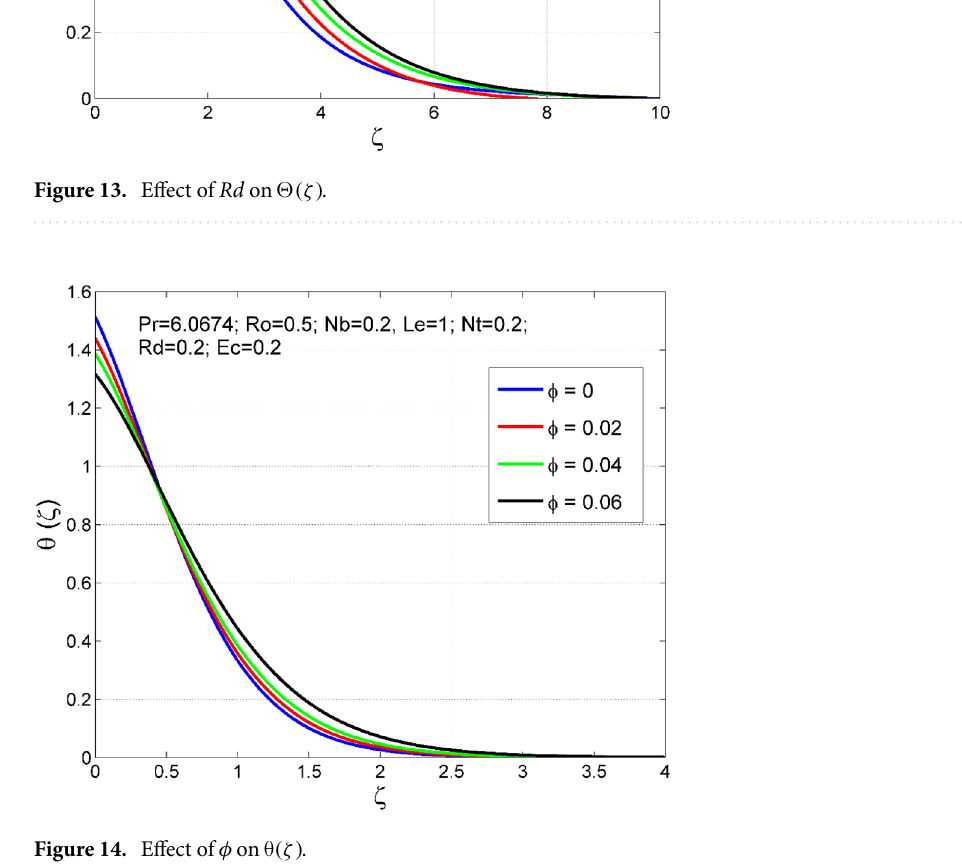
Figure 14. Effect of φ on θ (ζ)